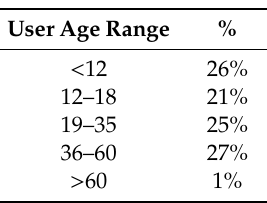
Table 4. Age of users.